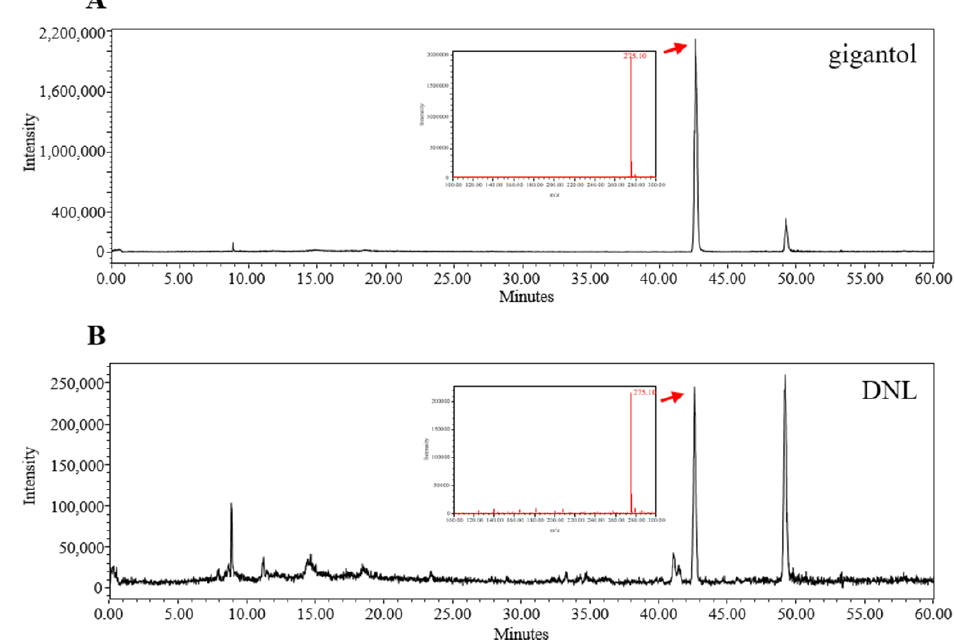
Figure 8. Liquid chromatography – mass spectrometry (LC – MS) of ( A ) gigantol and ( B ) DNL.